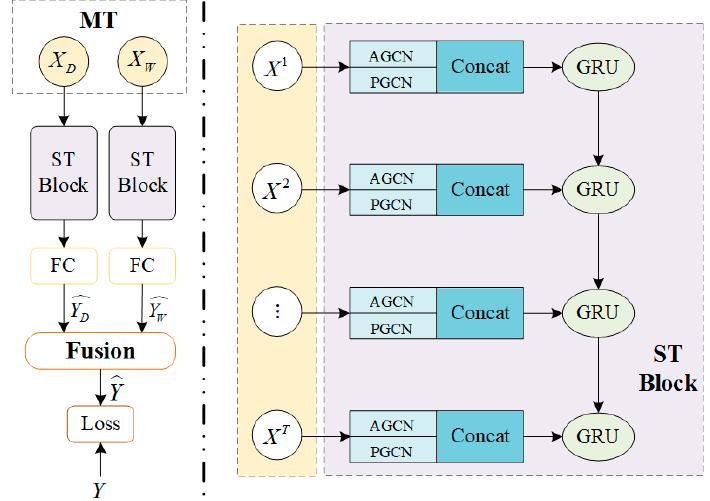
8 of 17 Figure 5. Model structure of the GRU.